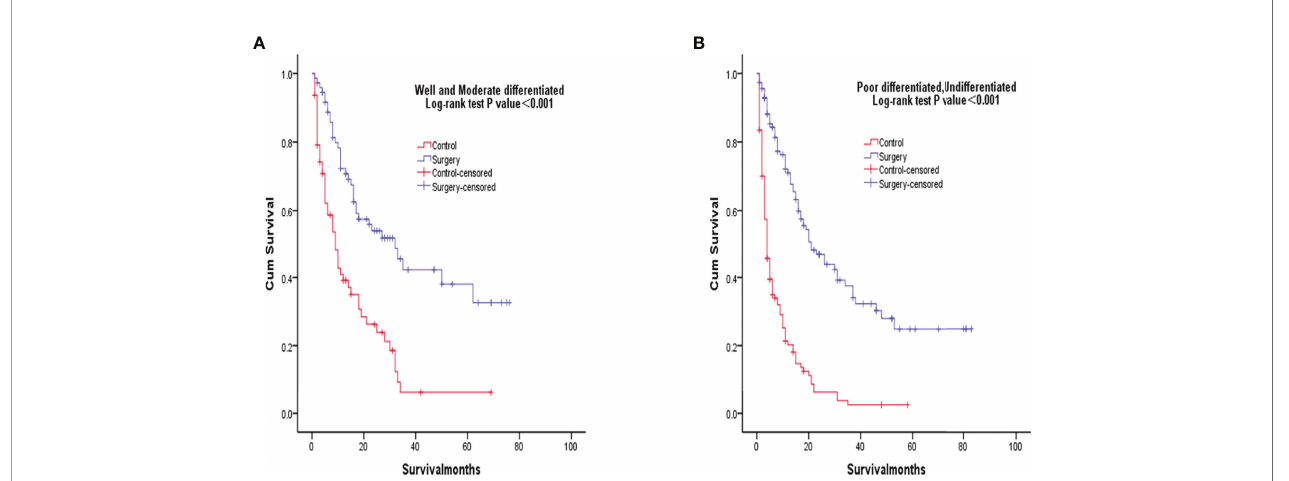
FIGURE 4 | Kaplan-Meier overall survival curves of surgery-treated patients vs control after propensity score matching strati fi ed by well and moderate (A) , poor and undifferentiated (B)